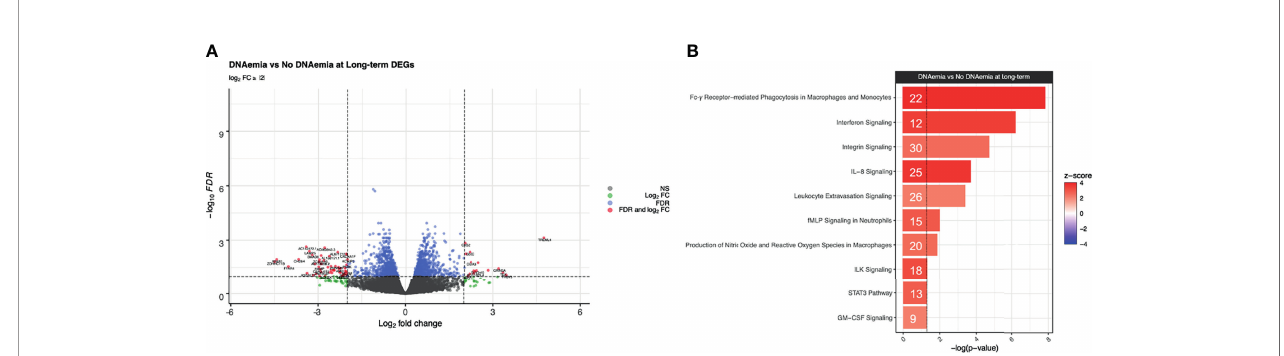
FIGURE 5 | Differential expression analysis at the long-term timepoint between DNAemia and no DNAemia. (A) Volcano plot of differentially expressed genes. Gray points represent genes that are not differentially expressed, green points represent genes that have a log 2 FC ≥ 2 but not differentially expressed, blue points represent genes that are differentially expressed (FDR ≤ 0.1) but have a log 2 FC < 2, and red points represent genes that are both differentially expressed (FDR ≤ 0.1) and have a log 2 FC ≥ 2. (B) Bar plot of IPA canonical pathways enriched for patients with history of CMV DNAemia compared with those without history of DNAemia at the long- term time point. The signi fi cance of an enriched pathway is represented by the length of each bar, where length corresponds to the -log(p-value). The number of genes enriching for a pathway is indicated in the bar. The vertical dotted black line corresponds to a p-value of 0.05. Positive IPA Z-scores are indicated in red.